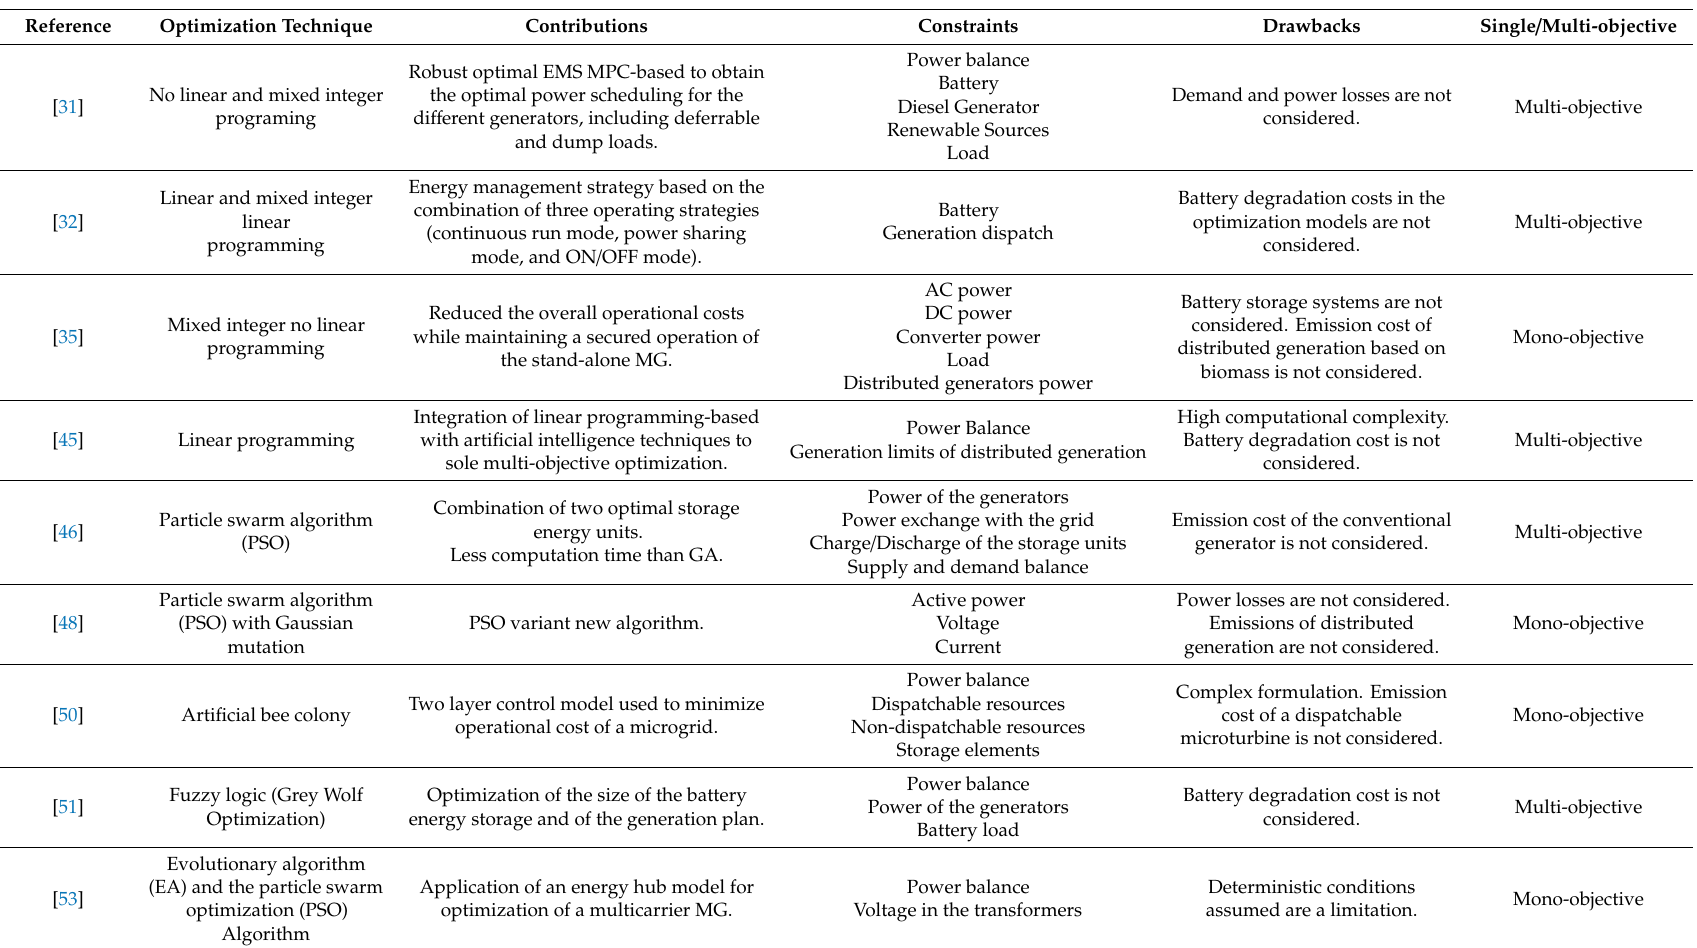
Table 3. Analysis of microgrid optimization